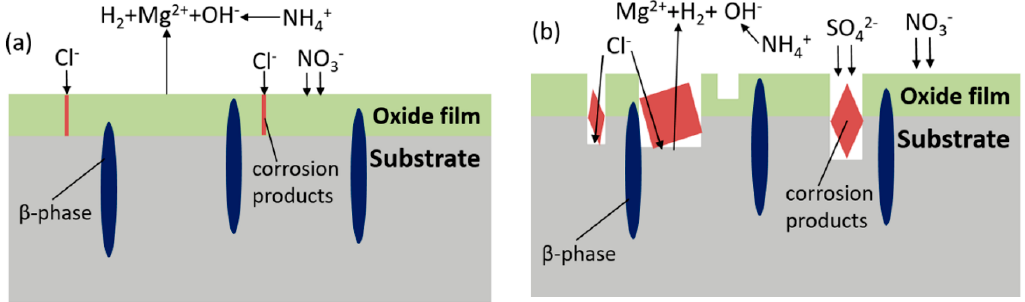
Figure 16. Corrosion process diagram of AZ91D consisting of a first stage ( a ) and a second stage ( b ) immersed in HA solution.